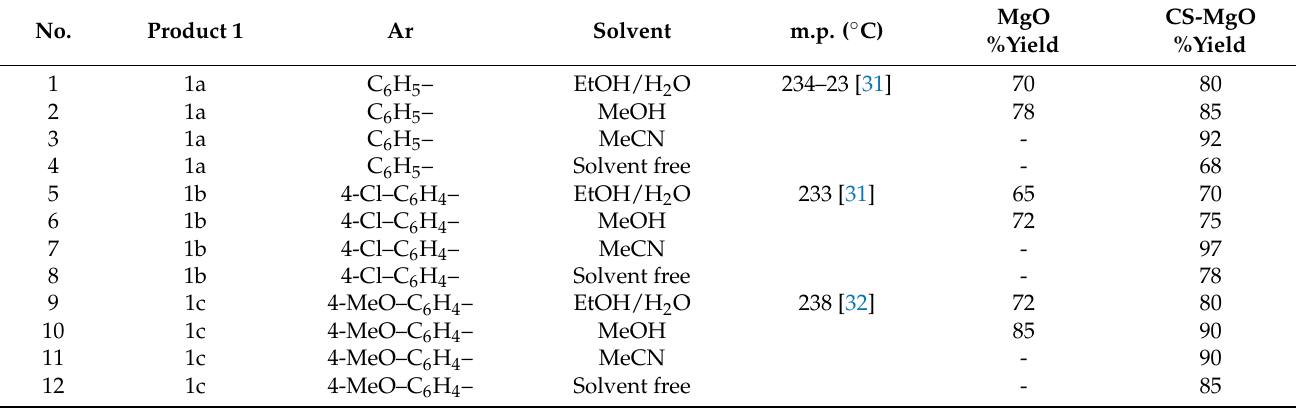
Table 1. Data comparing catalysts and solvent for one pot reaction forming diaminopyrimidine-5-carbonitriles (Scheme 2). No.